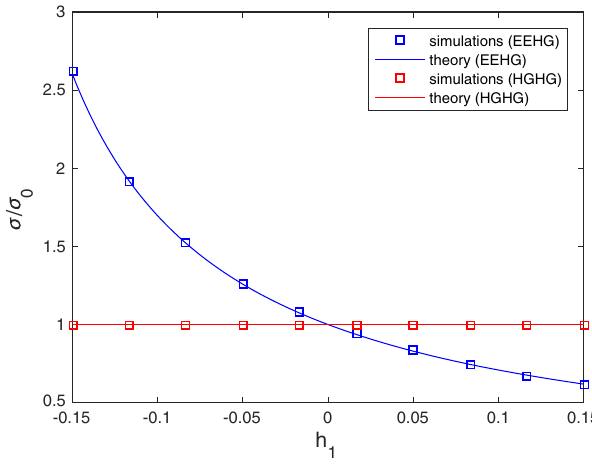
FIG. 5. Harmonic bunching bandwidth as a function of linear chirp. For EEHG a E ¼ 10 , m ¼ 11 , K ¼ 1 , B 1 ¼ 3 . 73 , and A ¼ 3 . For HGHG a ¼ A ¼ 10 and B ¼ 0 . 11 . Numerical 1 ; 2 H 1 1 particle simulations written in MATLAB